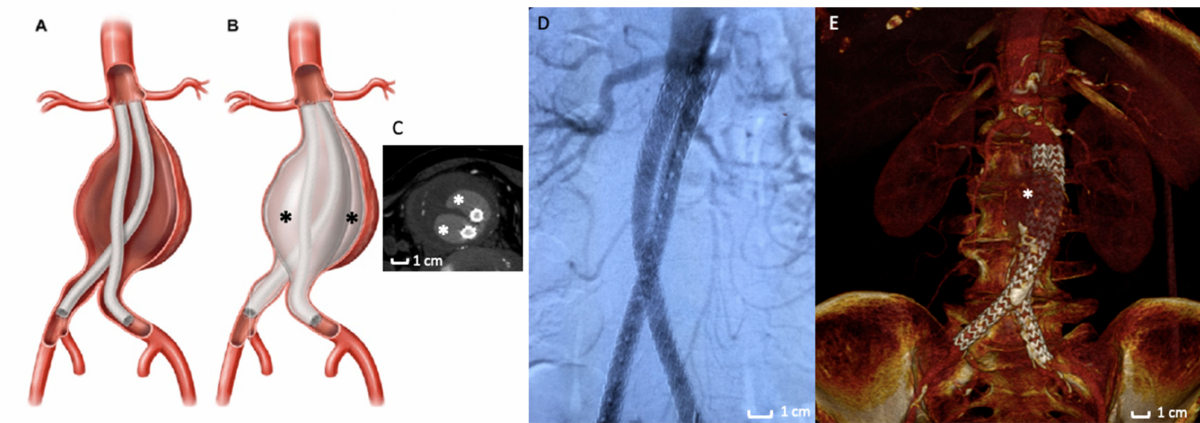
Figure 2. Nellix stent graft. ( A , B ) Picture of Nellix endograft during the endobags’ polymer filling maneuvers. The asterisk (*) indicates the endobags that adapt to the morphology of the entire aneurysm sac. ( C ) Axial Computed Tomography Angiography detail of a Nellix endograft implanted. The stent grafts (arrows) are located in the middle of endobags, which are filled with polymer (*). ( D ) Intraoperative image of the Nellix stent graft deployed with angiographic contrast medium that highlights the good patency of the endograft and the exclusion of AAA. ( E ) 3D volume rendering of Computed Tomography Angiography at 3-months follow-up post-implantation that reveals a good aneurysm exclusion. The asterisk (*) indicate the polymer-filled